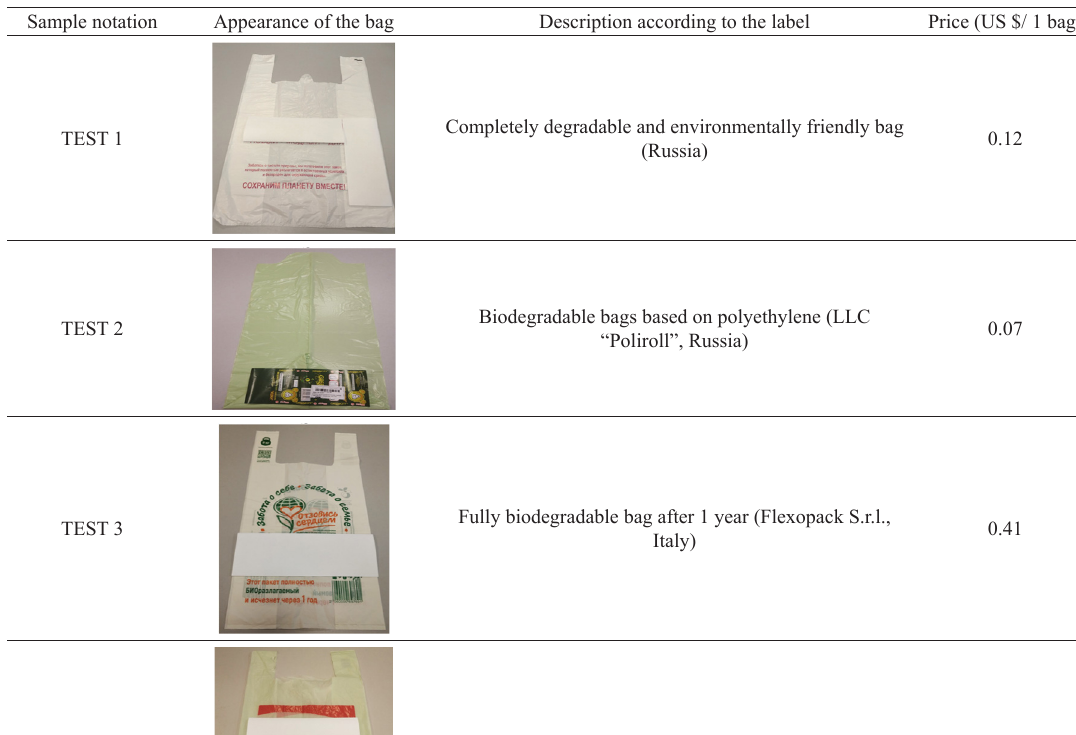
Table 1. The description of the bags under